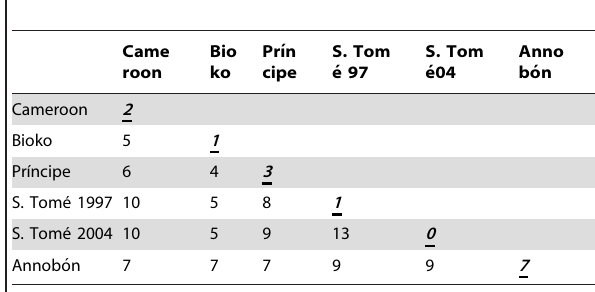
Table 2. Distribution of shared Herves sites among populations of An. gambiae in the Gulf of Guinea.